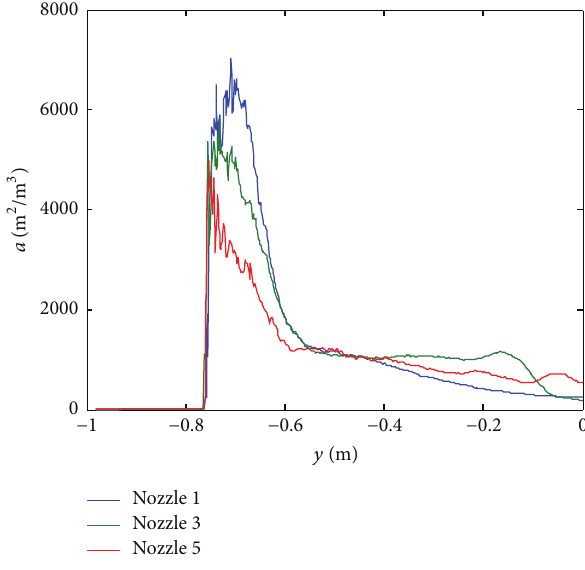
Figure 22: Plot of the interfacial